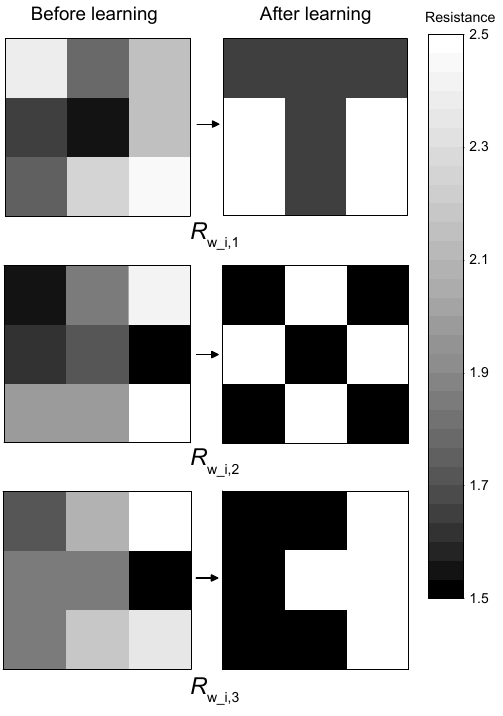
Figure 10. Distribution of resistances R w_i, 1 , R w_i, 2 , and R w_i, 3 before and after training.